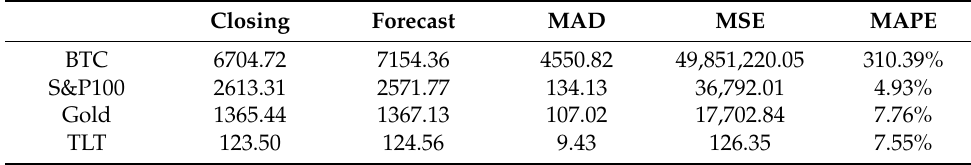
Table 3. Evaluation indicators for financial